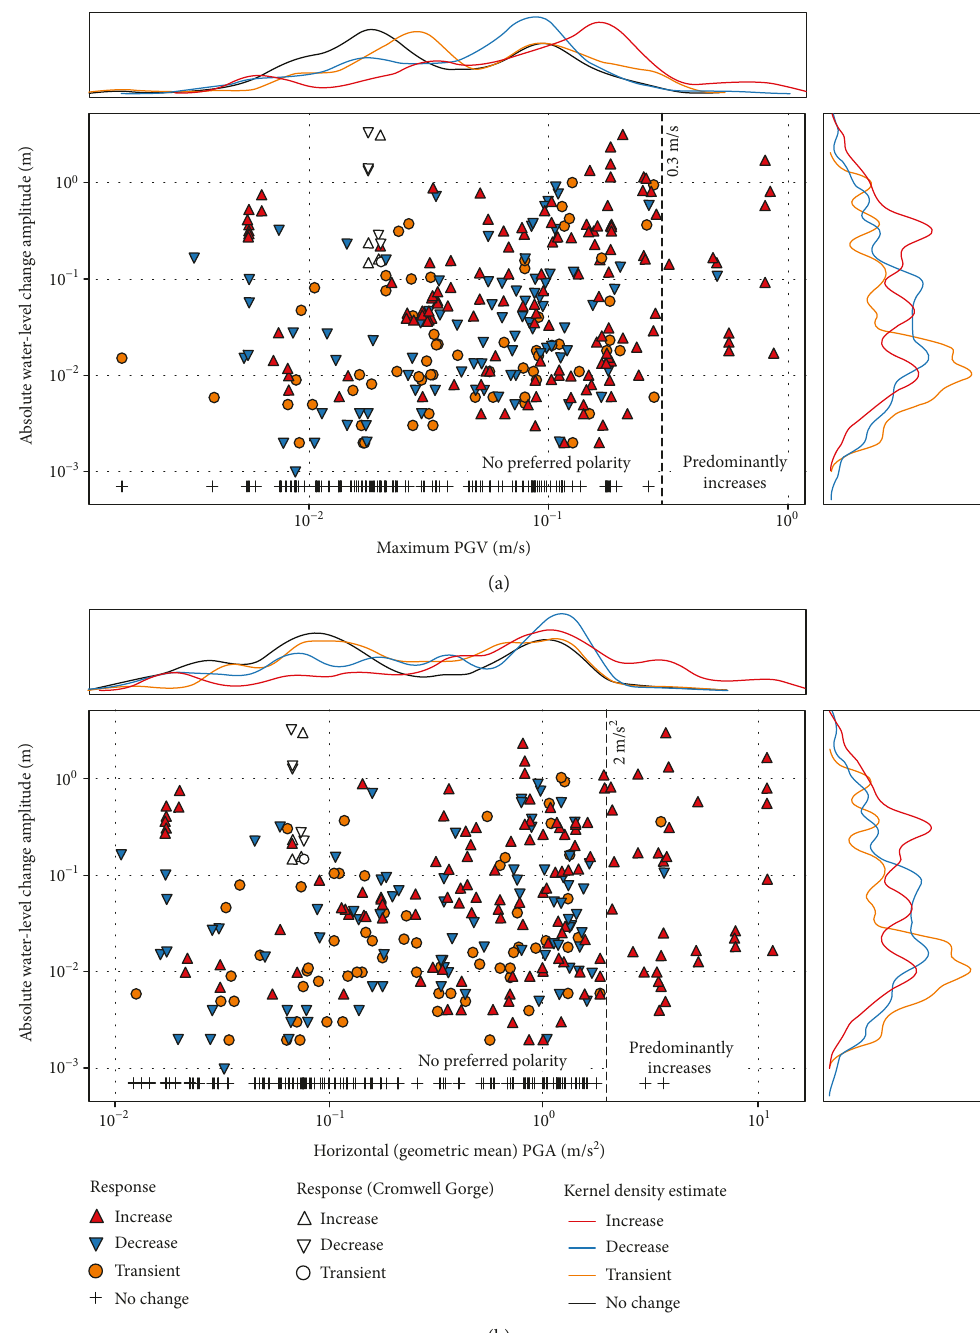
Figure 7: Absolute water level change amplitude as a function of (a) maximum PGV and (b) horizontal (geometric mean) PGA. Above a PGV of ~ 0.3m/s and a PGA of ~ 2m/s 2 , water level changes were predominantly